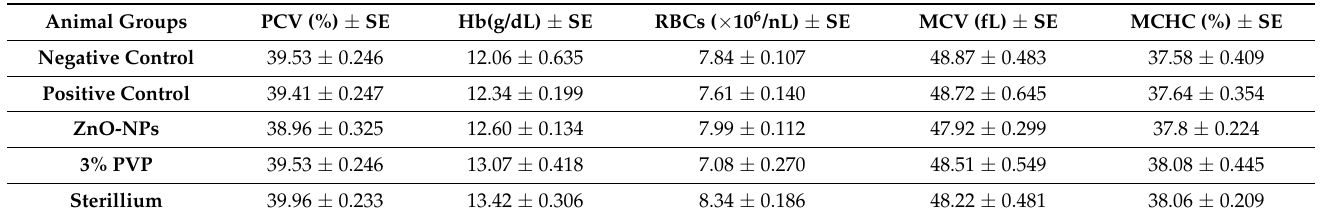
Table 6. Erythrogram of different experimental groups; * data are presented as mean ± Standard Error (SE) and results are averages of five independent readings.